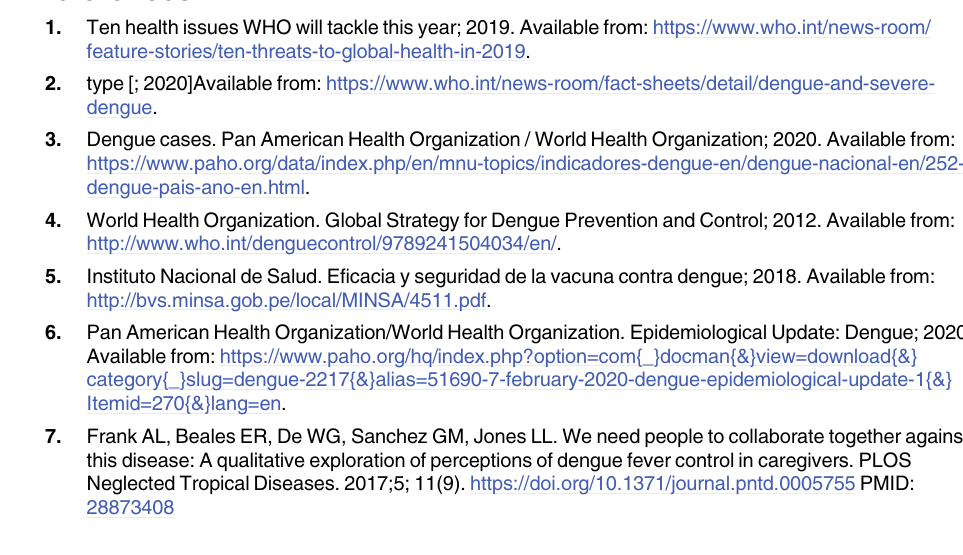
S1 Fig. Partial autocorrelation functions for temperature and precipitation model and for all El Ni ñ o models for a random sample of 10 districts. Autocorrelation is indicated by taller bars at shorter lags (i.e., decreasing bar heights from left to